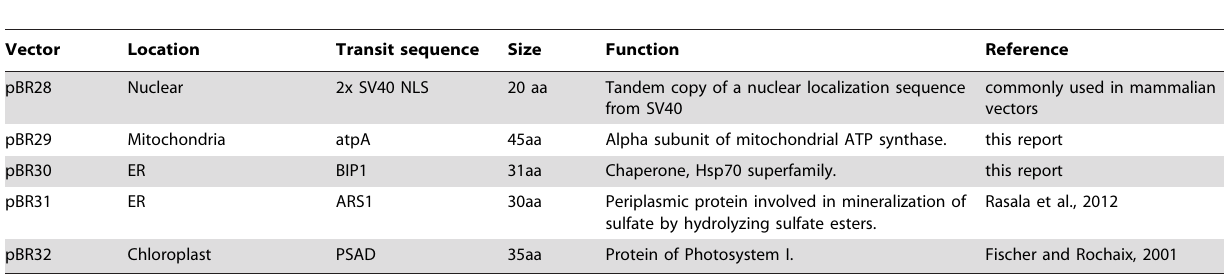
Table 1. Summary of transit peptides and targeting sequences used in this